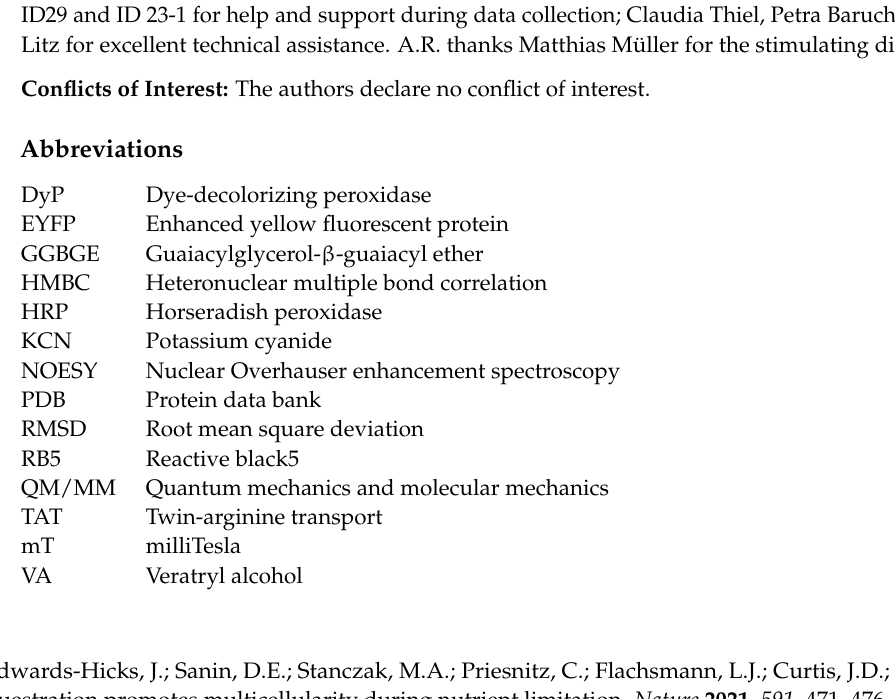
Table S1: Data collection and refinement statistics (values in parentheses are for the outer